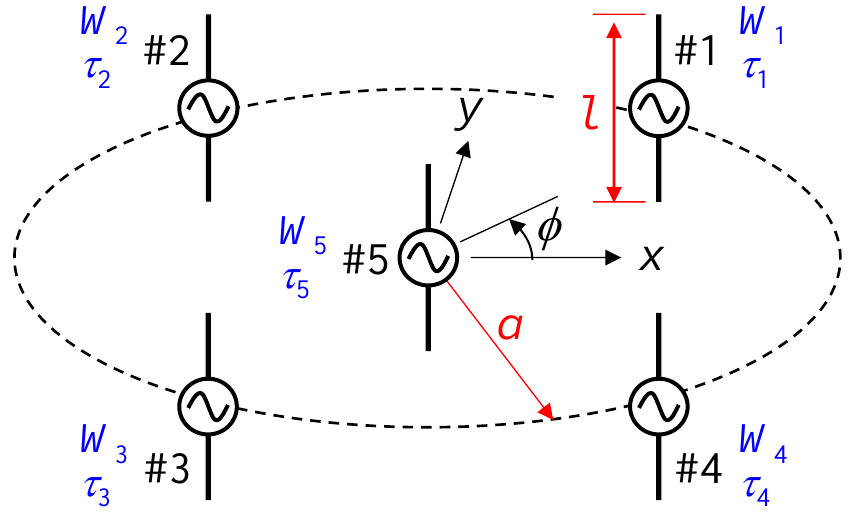
Figure 2. Configuration of the smart gateway antenna.